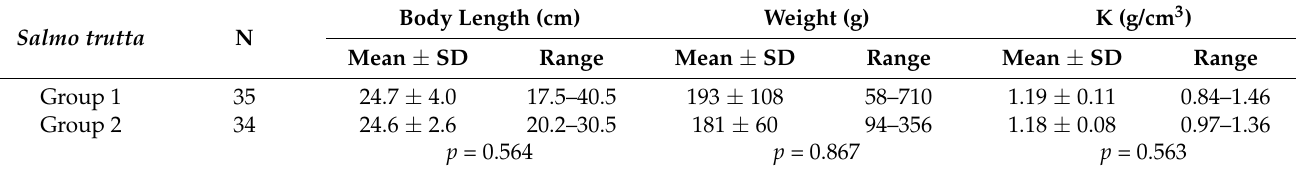
Table 2. Fish samples. N: number of tagged fish. SD: Standard Deviation. Range: minimum and maximum. K: condition factor (100 × weight/length 3 ). The p corresponds to the p -value of the Student’s t -tests for comparison between groups. Fork length was the body length type